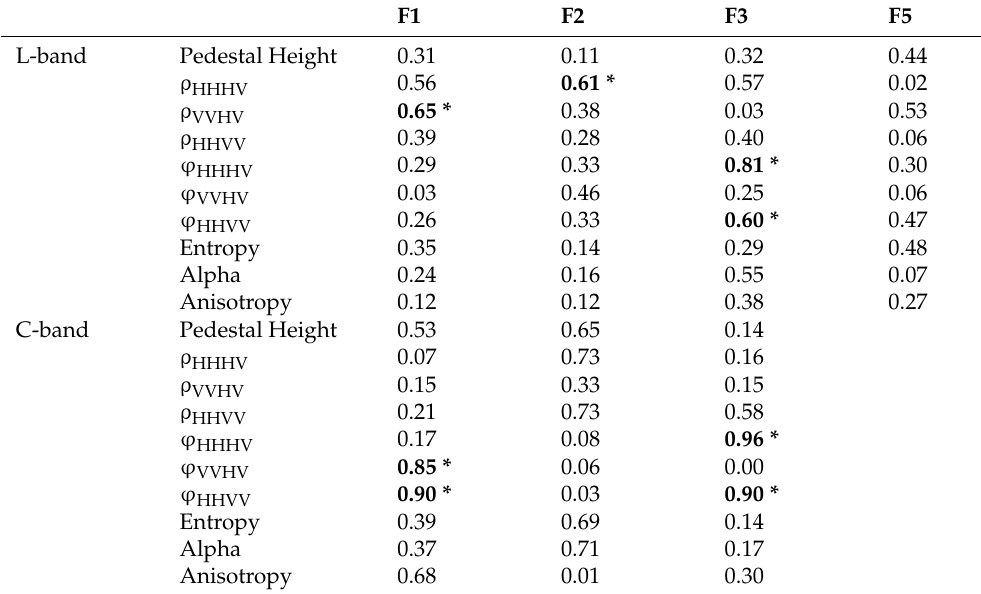
Table 10. Correlation coefficients of the mean values of polarimetric parameters to the soil moisture at L-band ( θ = 30°) for F1, F2, F3, and F5 sites and at C-band for F1, F2, and F3 sites. Significant correlations ( p -value < 0.05) are shown with ‘*’.